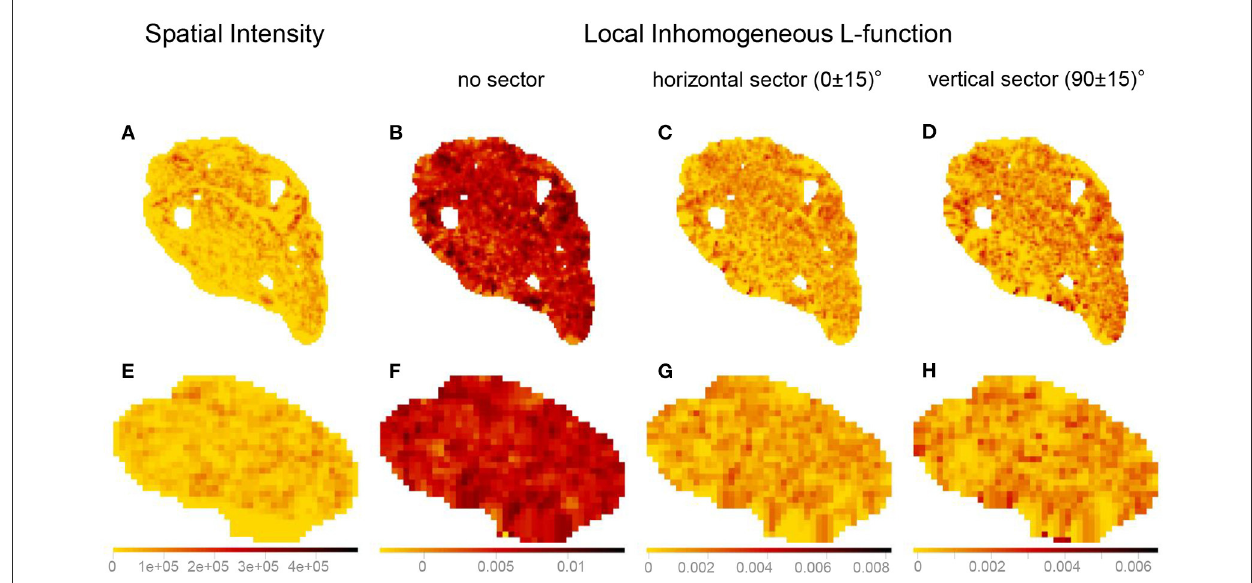
FIGURE11 Visualizing the kernel-smoothed spatial features of Image 3 (vagus) and Image 29 (pelvic) listed in Table 1. (A, E) Spatial intensity. (B, F) Local inhomogeneous L -function. (C, G) Local inhomogeneous L -function with the horizontal sector. (D, H) Local inhomogeneous L -function with the vertical sector. The scale bars show the range of values for each spatial feature separately (column-wise). The kernel-smoothed bitmaps were downsampled for reasonable runtime and memory